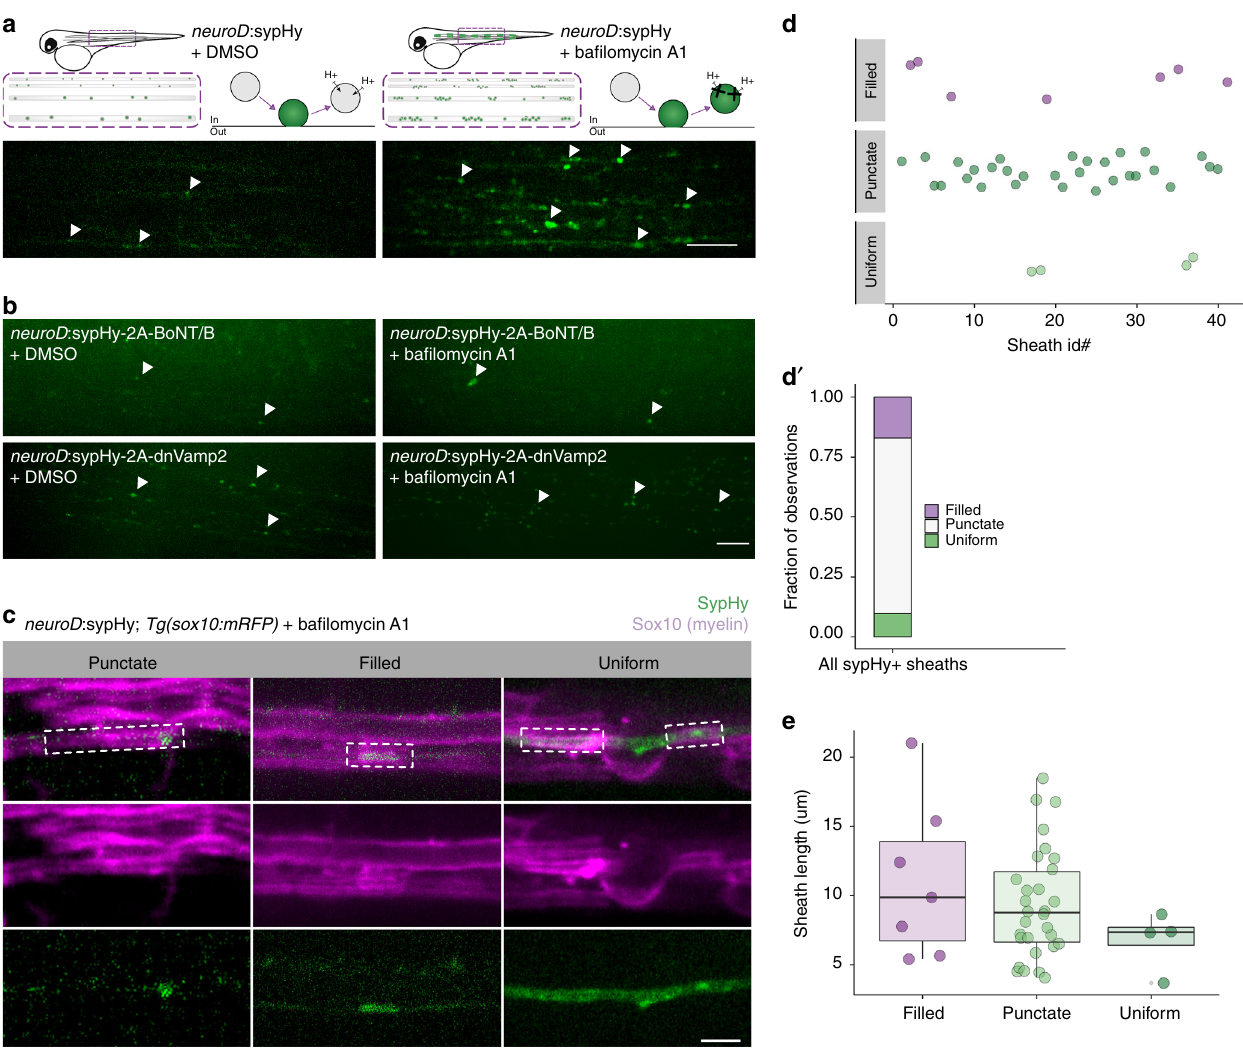
Fig. 2 Variable synaptic vesicle exocytosis sites under myelin sheaths. a Left, schematic of Syp-pHluorin (SypHy) function and transient expression in spinal cord neurons and representative max-projection image of a live 4 dpf larva expressing neuroD :sypHy. Arrowheads indicate dim spots of SypHy signal. Right, similar but in the presence of ba fi lomycin A1 to inhibit vesicle reacidi fi cation. Note appearance of several large SypHy + “ hotspots ” along axons. Scale bar, 10 µ m. b Similar to a except larvae are co-expressing inhibitors of exocytosis, botulinum toxin (BoNT/B) or dominant-negative Vamp2 (dnVamp2). Both BoNT/B and dnVamp2 suppress ba fi lomycin induction of SypHy hotspots. Arrowheads indicate a few visible SypHy spots. Scale bar, 10 µ m. c Expression of neuroD :sypHy in Tg(sox10:mRFP) larvae treated with ba fi lomycin reveals three types of SypHy-reported exocytosis sites under myelin sheaths: punctate, fi lled, and uniform. Boxes outline individual myelin sheaths. Scale bar, 5 µ m. d Classi fi cation plot of SypHy signal under 41 sheaths (from n = 20 larvae) by category. Presented as a bar in d ′ for visible contribution of each category to the total. e No association between category and